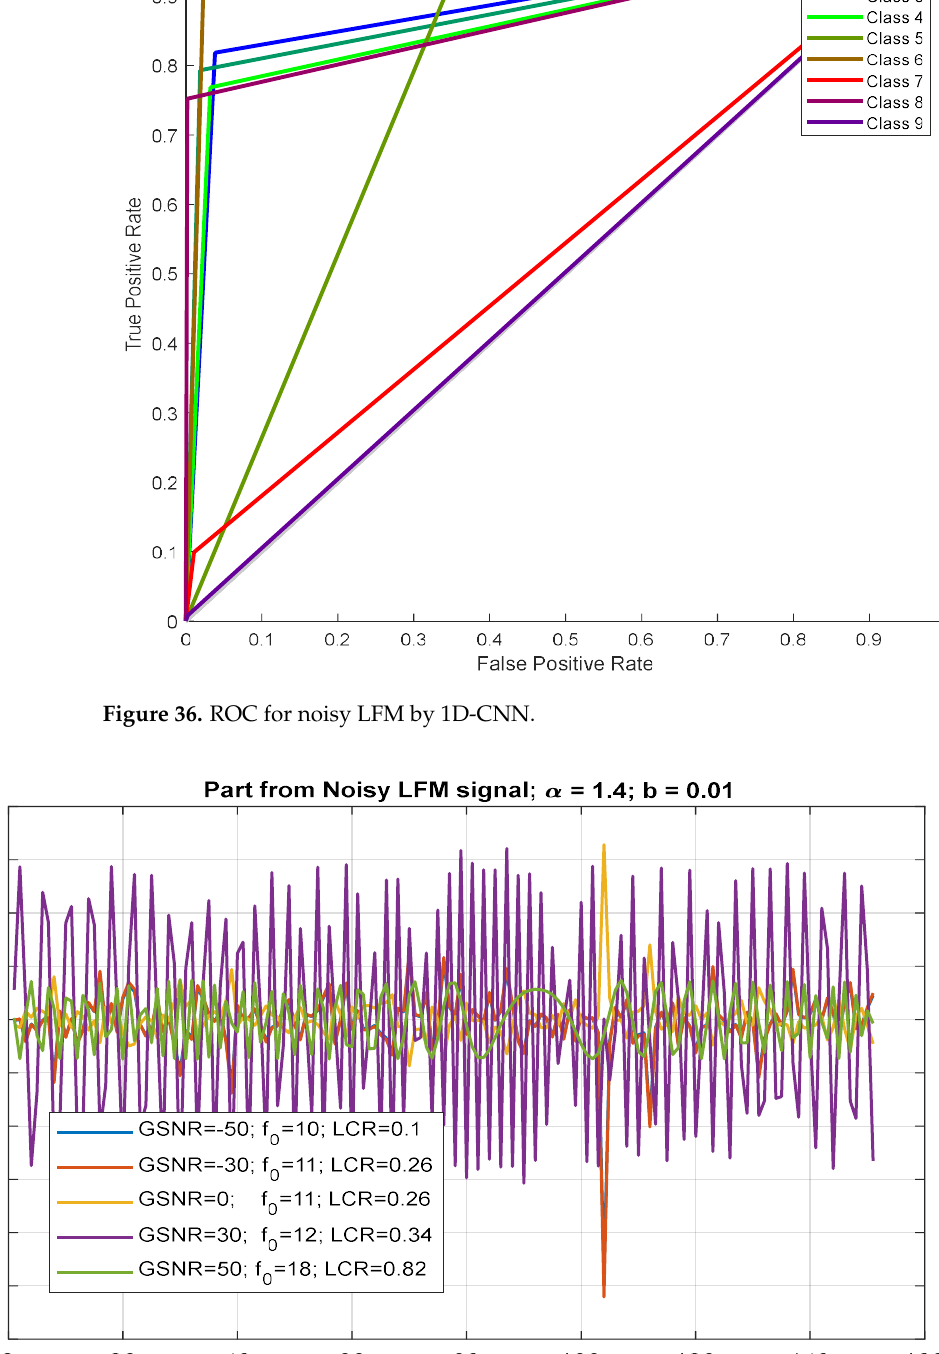
Figure 38. 2D-signals in the time domain.